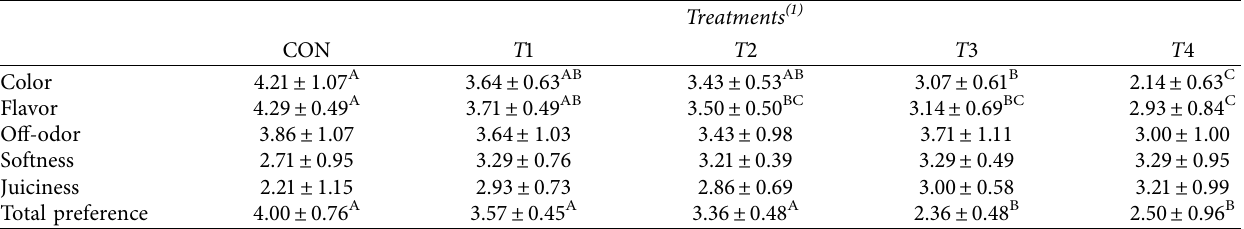
Table 7: Sensory properties of the hybrid beef patty with shiitake mushroom ( Lentinus edodes ).